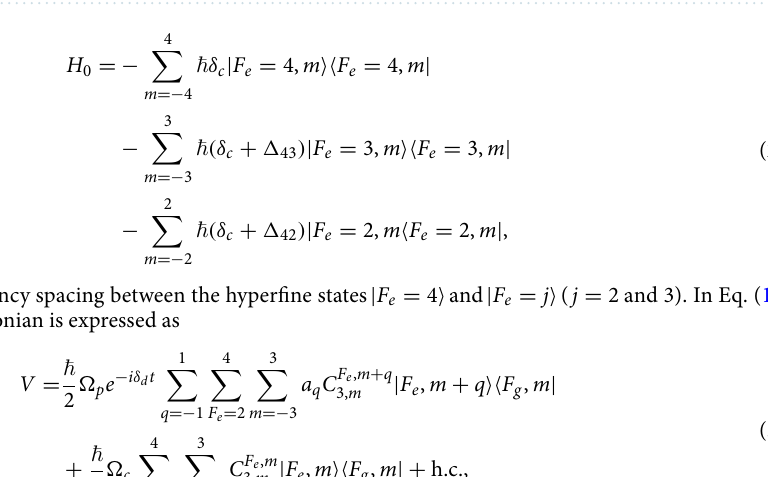
Figure 1. ( a ) Energy-level diagram of D2 transition lines of an 85 Rb atom, wherein the red and blue lines indicate transitions by the probe and coupling beams, respectively. ( b ) Transition scheme with two linearly 3 4 transition, where “0” (blue lines) and “ δ F e polarized coupling and probe beams in the case of F g = → = (red lines) denote the transitions excited by the coupling and probe beams, respectively. To avoid confusion, the 3 2 and 3 transitions are not F e excitations for the F g = → =